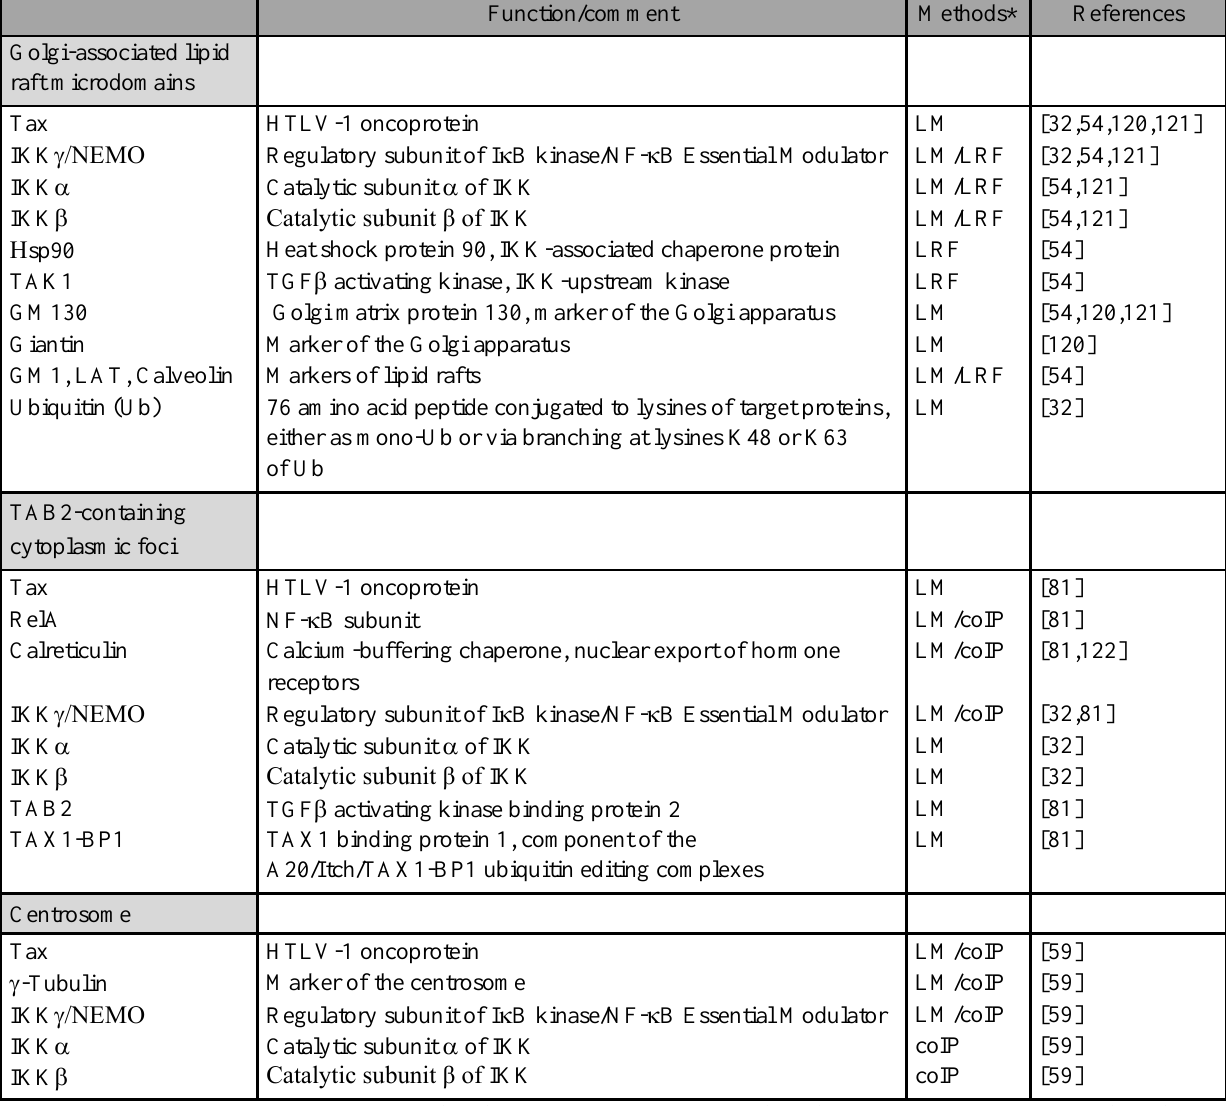
Table 2. Tax cytoplasmic foci